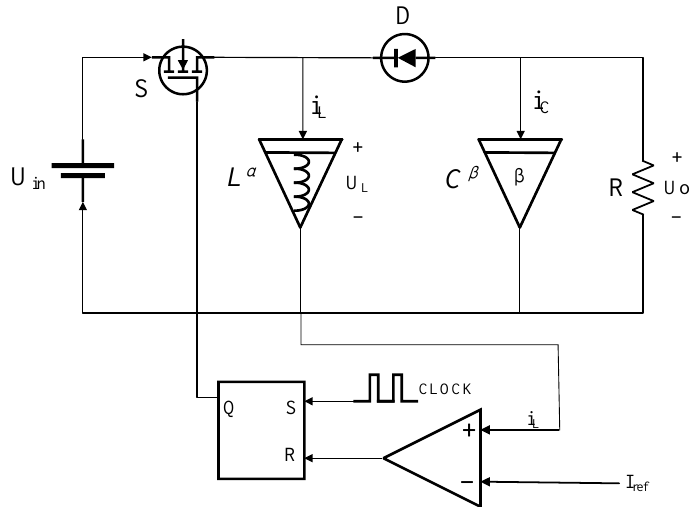
Figure 1. The peak current controlled FO buck – boost converter circuit topology. The inductance current waveform when the converter operates in DCM mode is shown in Figure 2.